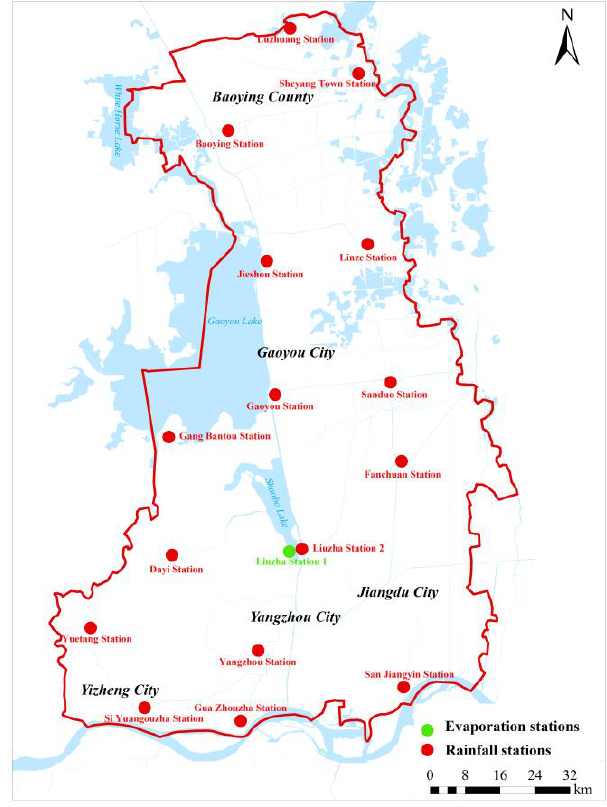
Figure 2. Spatial distribution of rainfall and evaporation stations.